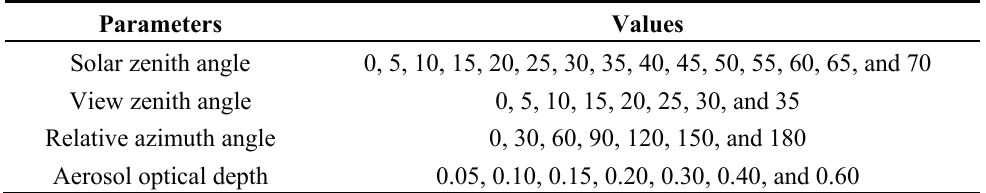
Table 2. Configurations for simulating surface albedo and TOA reflectance